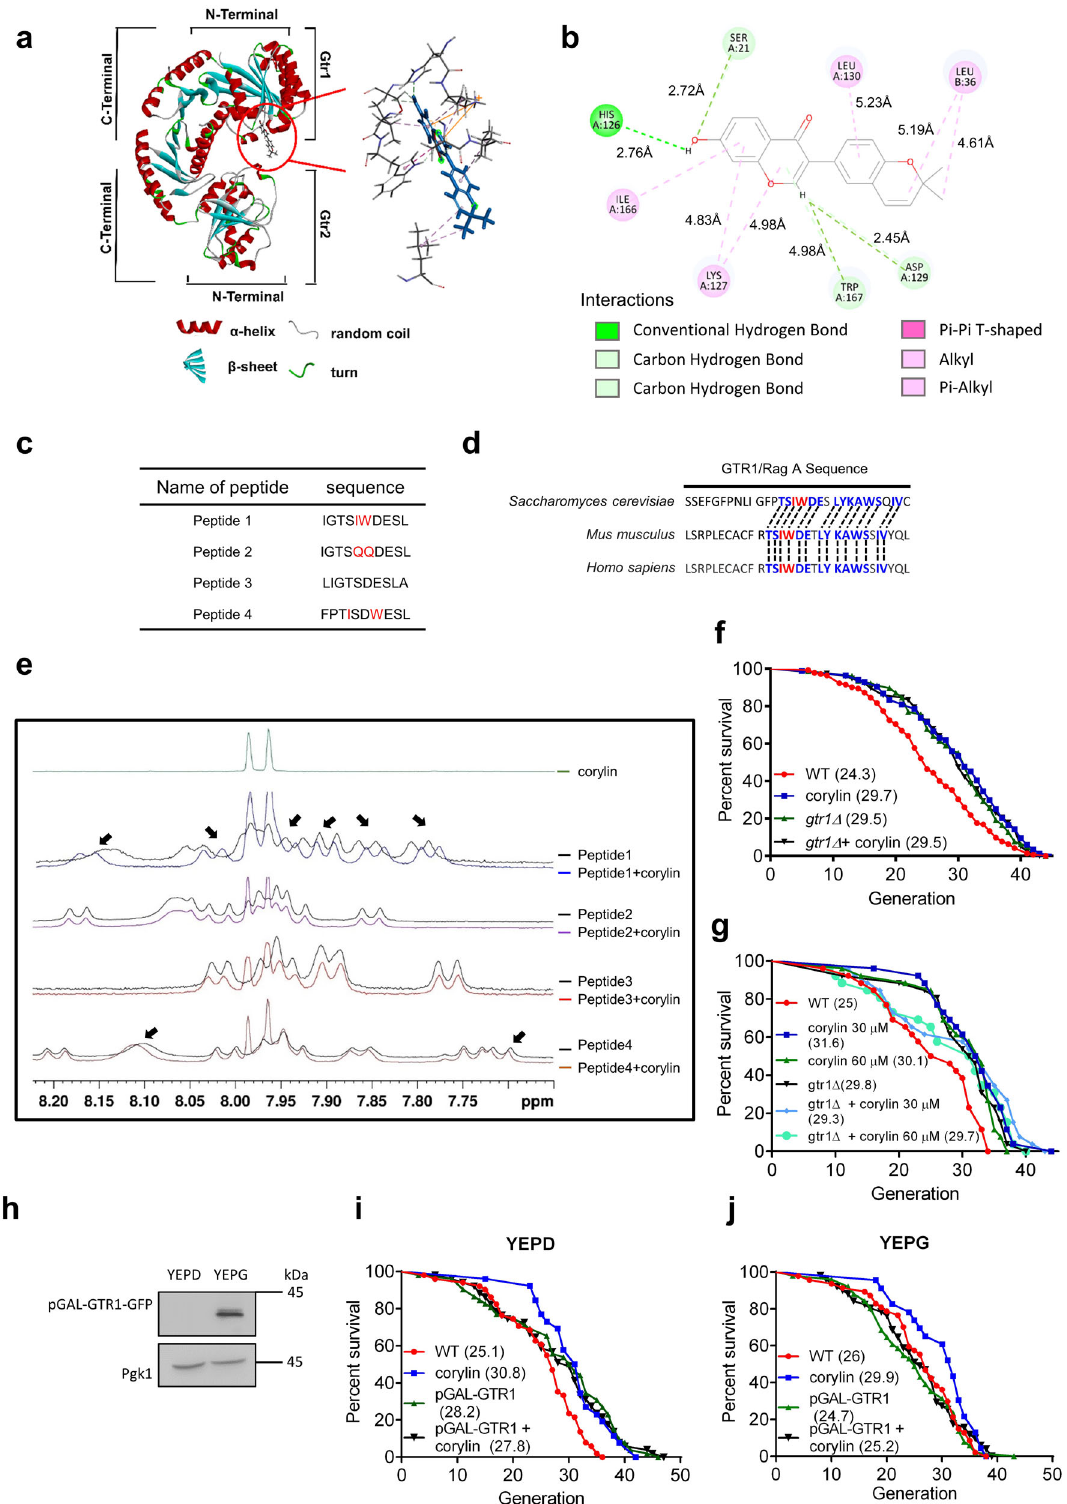
activates multiple pathways to increase the lifespan of yeast. This fi nding may also justify our conclusion that corylin extends lifespan in a Sir2-independent